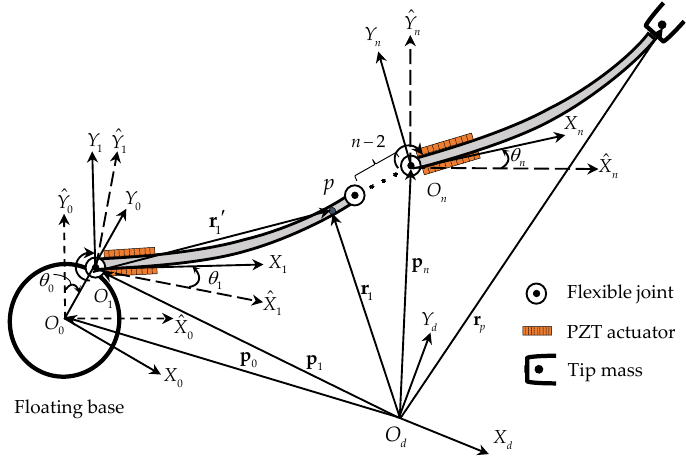
Figure 1. Schematic of a flexible manipulator system. Table 1. Kinematic and dynamic symbols of the space manipulator system.